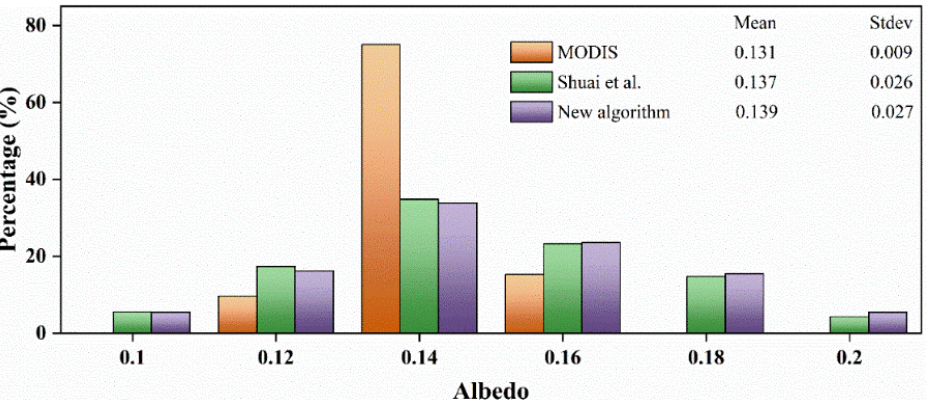
Figure 9. Histograms of the three black-sky albedo products shown in Figure 8. To test the spatial characteristics of the three albedo products, a random transect line was graphed in Figure 8, from which the data were picked up for spatial characteristics analysis. The results implied that the Landsat albedo retrievals had a better spatial expres- sion capability, because they were more dramatic and greater fluctuation than the MODIS product (Figure 10A). Figure 10B further qualitatively analyzes the spatial